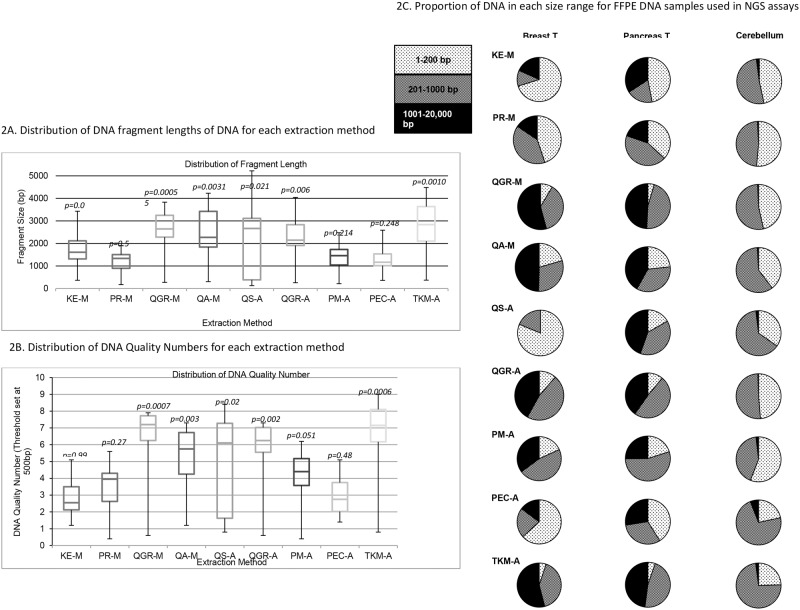
Fragment analysis.A: Distribution of DNA fragment length for each extraction method, B: Median DNA Quality number (DQN) for each method; a size threshold of 500bp was selected for assessment. C: Percent of fragments <200bp, 201–1,000bp, 1,001–20,000bp for three representative tissue types.